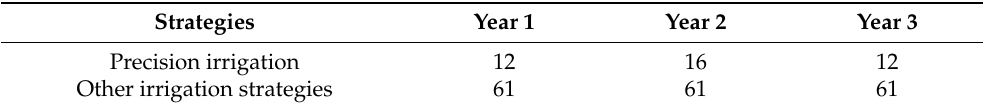
Table 4. Number of irrigation events during summer (July and August) for the Precision irrigation strategy compared with the rest of strategies.